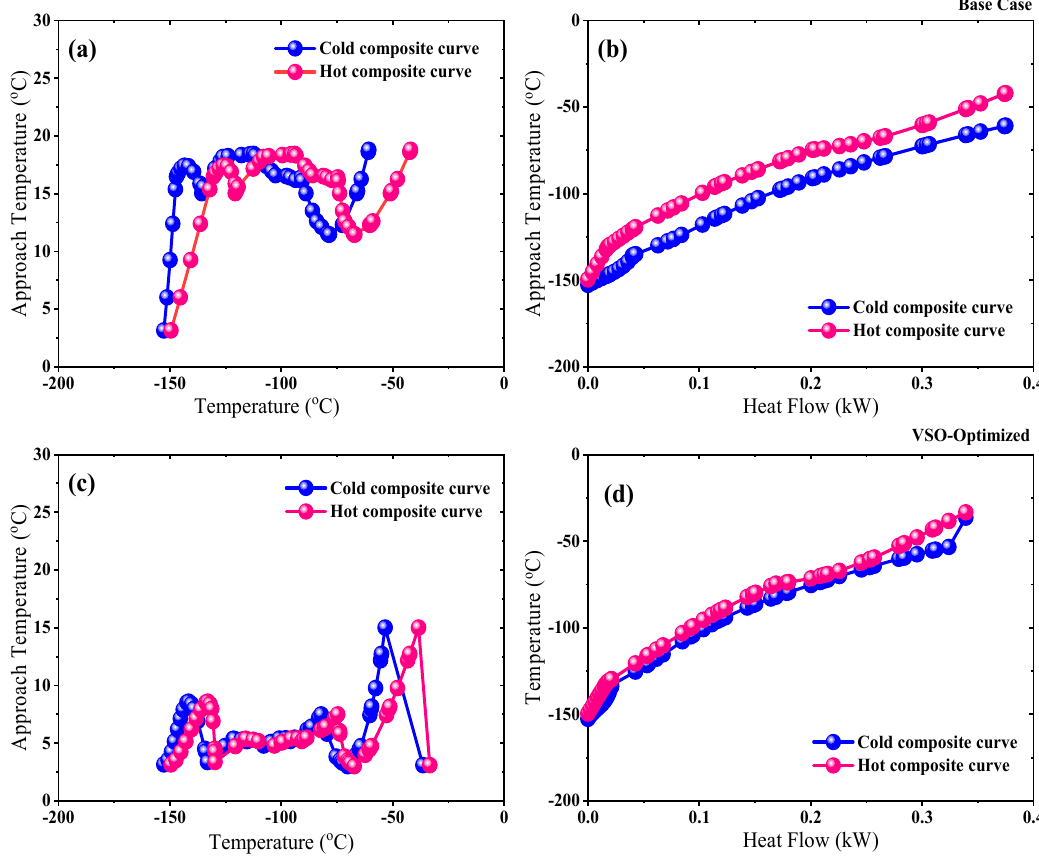
Figure 7. Base case ( a ) TDCC and ( b ) THCC curves in comparison with the VS-optimized ( c ) TDCC and ( d ) THCC curves of the C3MR process. Table 5. Temperature and pressure for all streams of SMR and C3MR